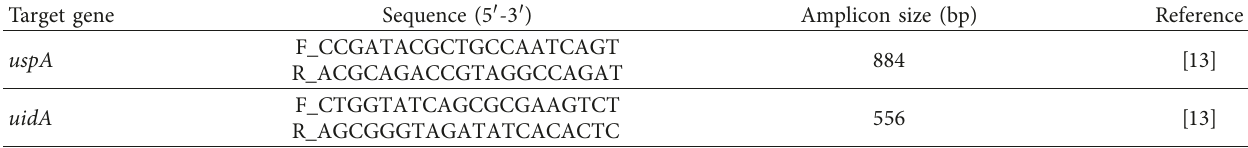
Table 1: Oligonucleotide primers used for the molecular identification of E.